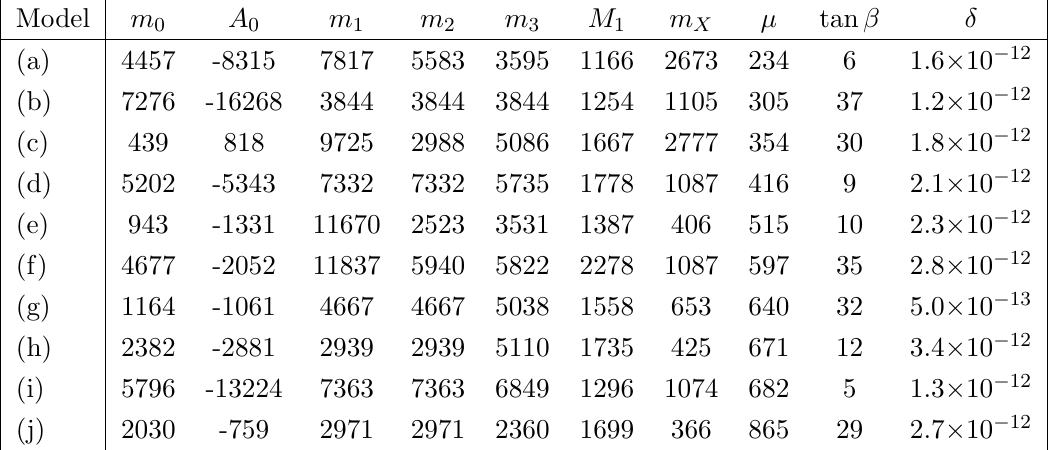
Table 1. Input parameters for the benchmarks used in this analysis. Here M 2 = M XY = 0 at the GUT scale. All masses are in GeV.